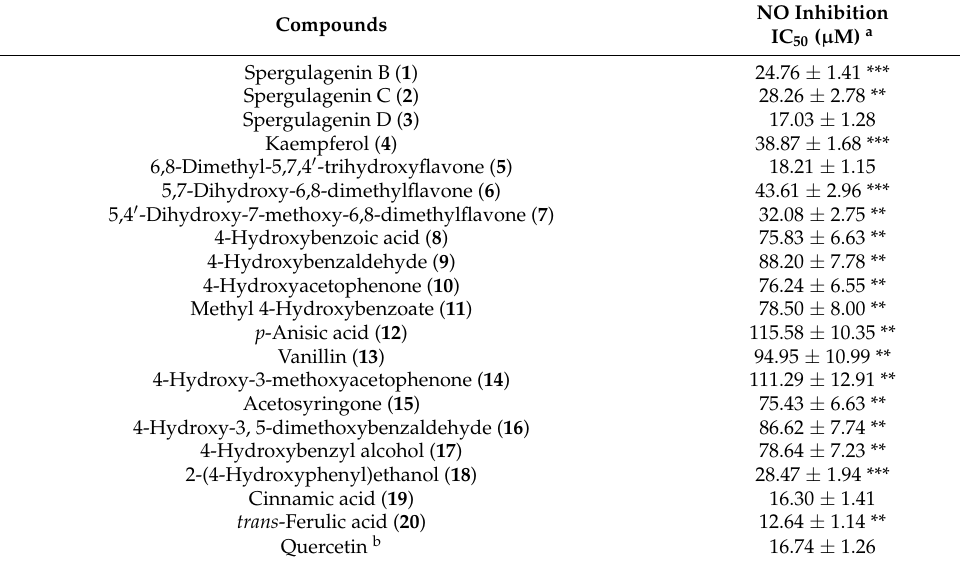
Table 3. Inhibitory effect of compounds 1 – 20 on production of nitric oxide in LPS-stimulated RAW 264.7 cells.